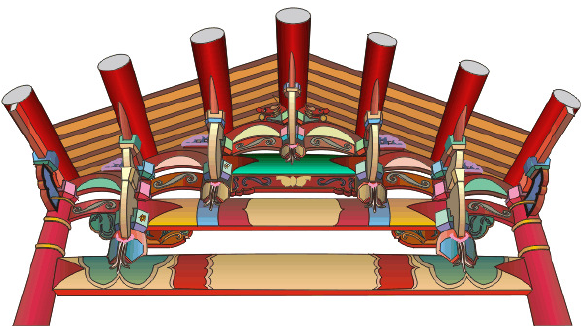
Fig. 1. An illustration of an historic building of the “Dei- Dou” timber frame